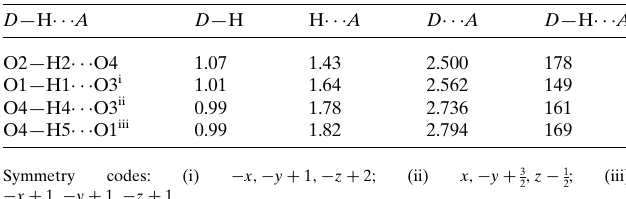
Table 2 Hydrogen-bond geometry (A˚ , (cid:5) ) for DUSJUX.